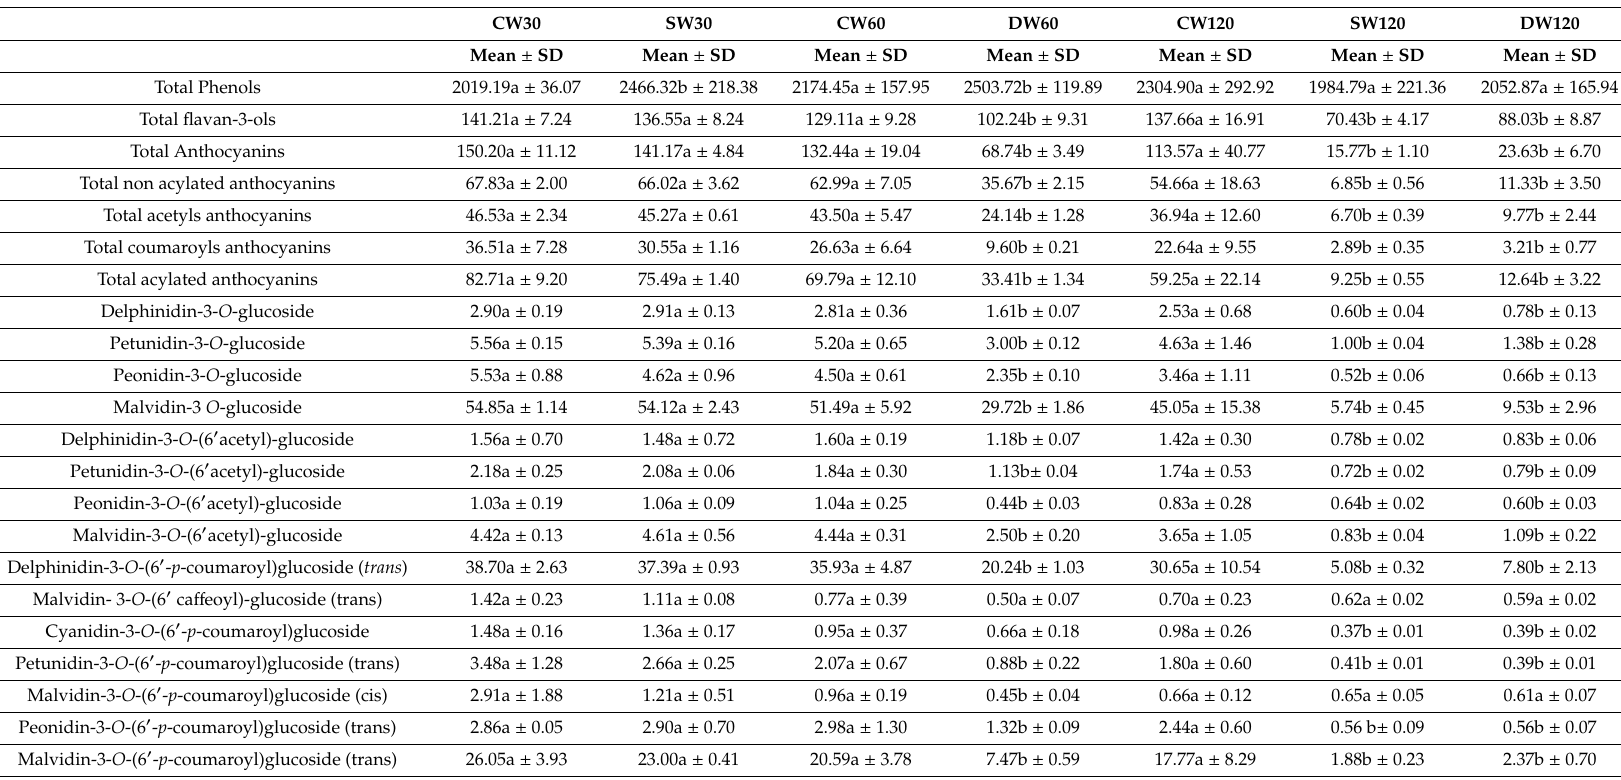
Table 1. Polyphenols content (mg L − 1 ) for the di ff erent elaborated wines (CW, SW and DW) in three di ff erent stages of the winemaking process. For each compound, di ff erent letters in the same row indicate statistical di ff erences (Tukey test, α =